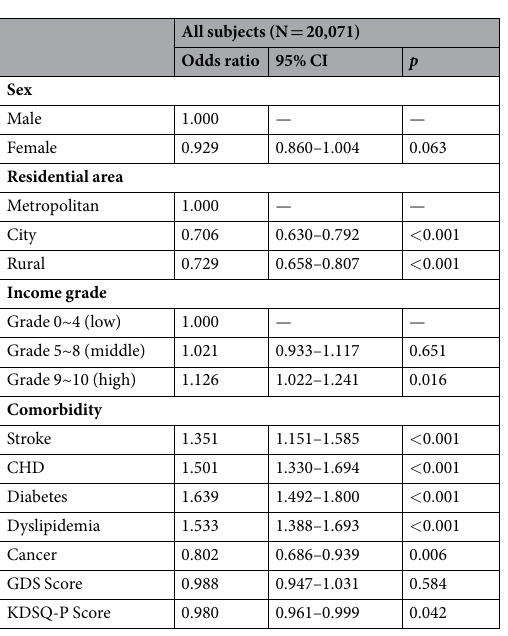
Table 2. Multivariate logistic regression analysis for association between cognitive function and medication adherence. CHD, coronary heart disease; GDS, Geriatric Depression Scale (range 0–3); KDSQ-P, Prescreening Korean Dementia Screening Questionnaire (range